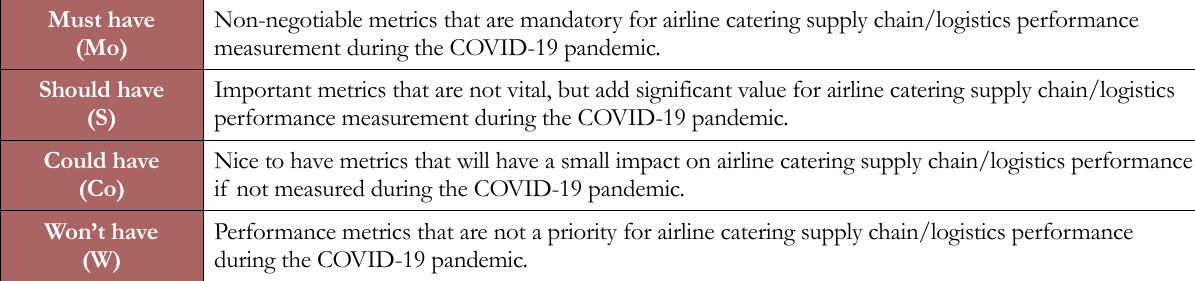
Table 2. Metrics